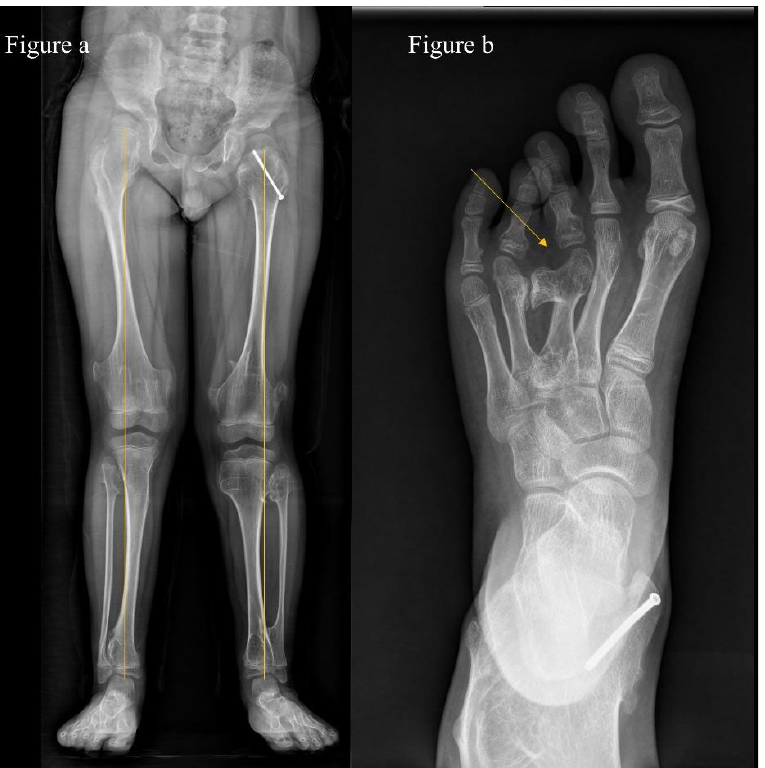
Figure 2. ( a ) An 8-year-old boy with multiple hereditary exostoses shows bilateral knee valgus deformity (14.2° on the left and 13.5° on the right) on the full-length standing anteroposterior view deformity (14.2 ◦ on the left and 13.5 ◦ on the right) on the full-length standing anteroposterior view of hip-to-ankle and ( b ) foot deformity due to bony mass of the 3rd metatarsal head.